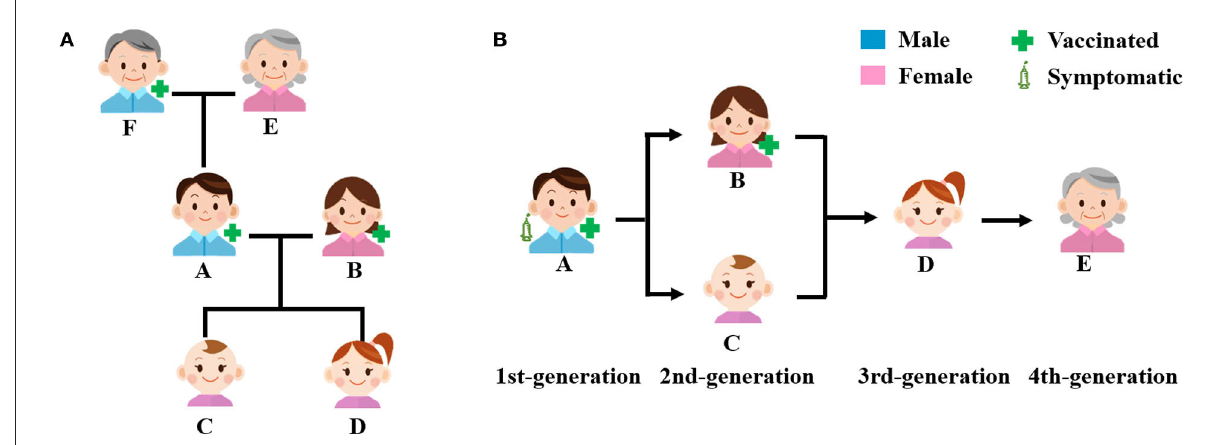
FIGURE1 Index case’s family members and the transmission chain. (A) Relationships of index case’s family members and (B) transmission